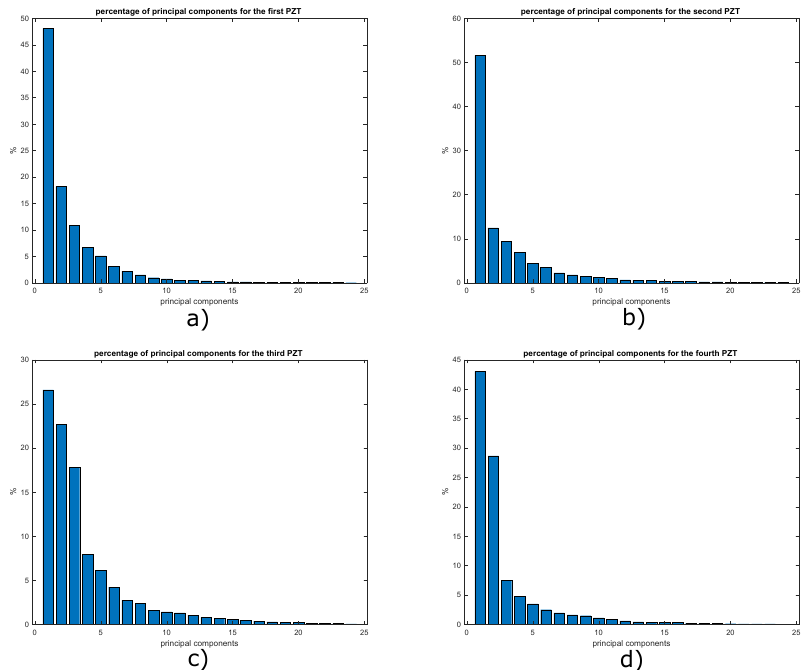
Figure 25. Variance distribution in: ( a ) phase 1; ( b ) phase 2; ( c ) phase 3 and ( d ) phase